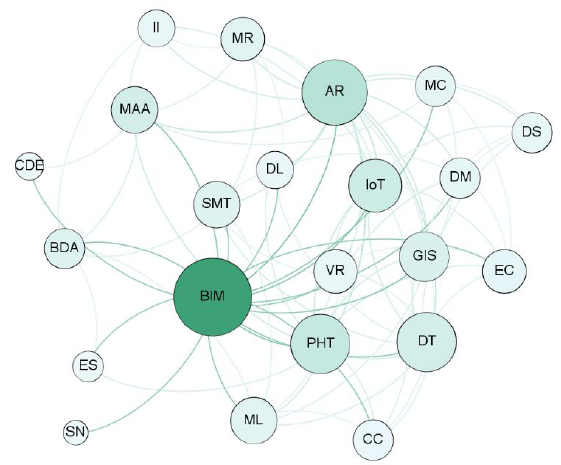
Figure 6. Analysis of intra-connections networks CT—betweenness.